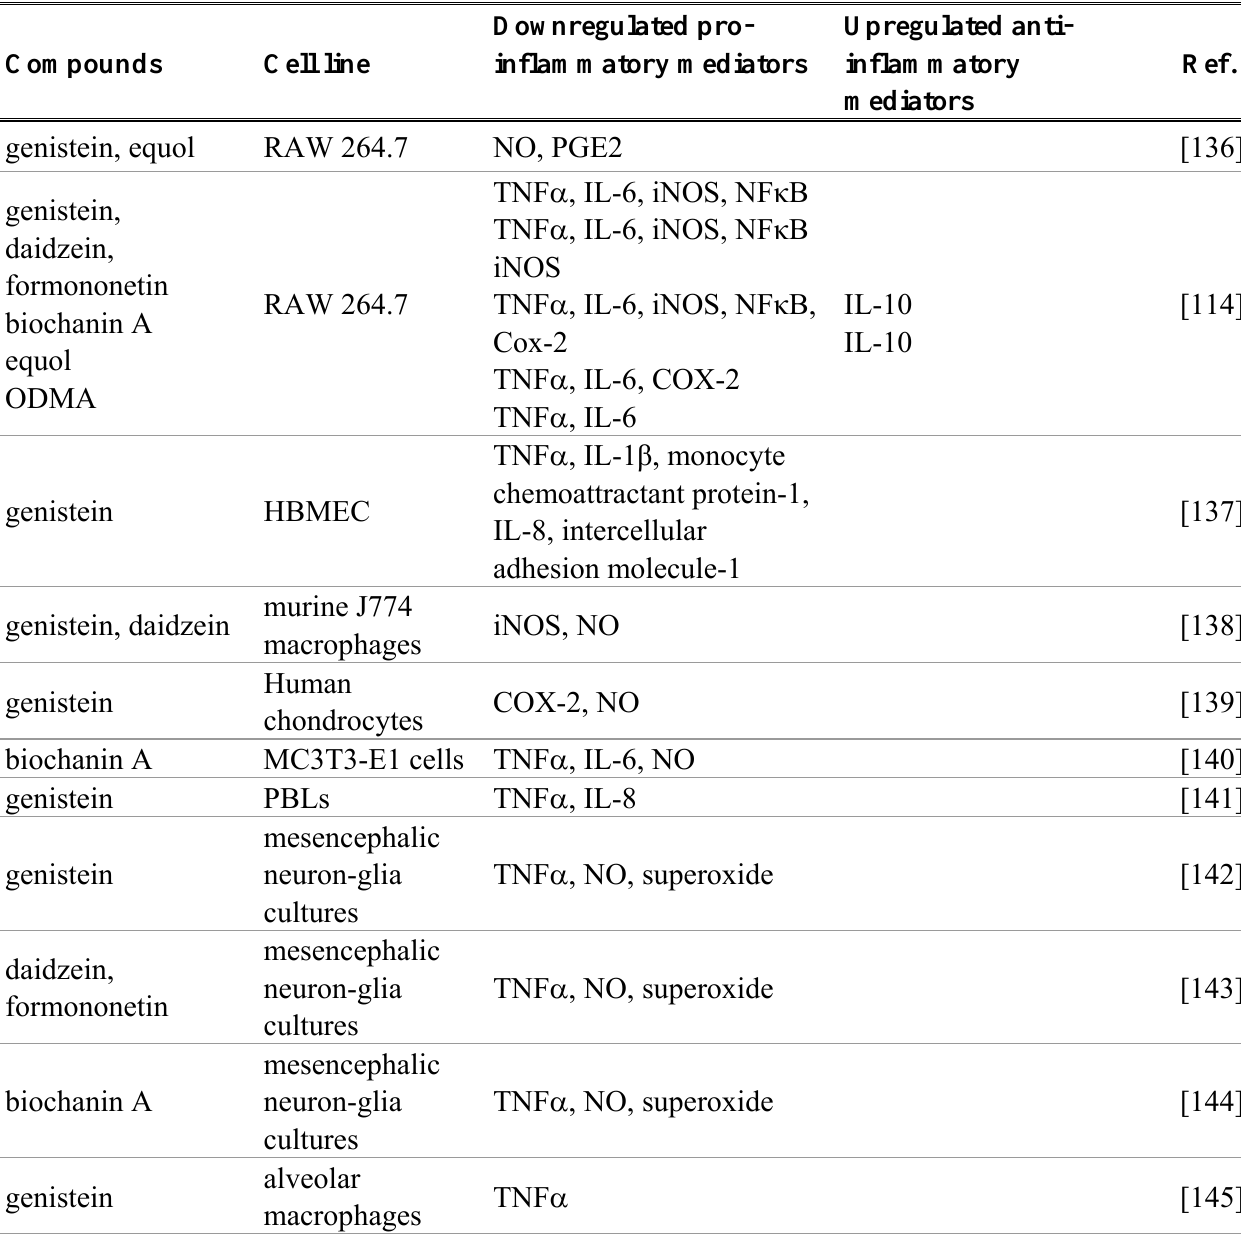
Table 2. Influence of isoflavones on the secretion of various inflammatory markers in cell lines. Compounds Cell line